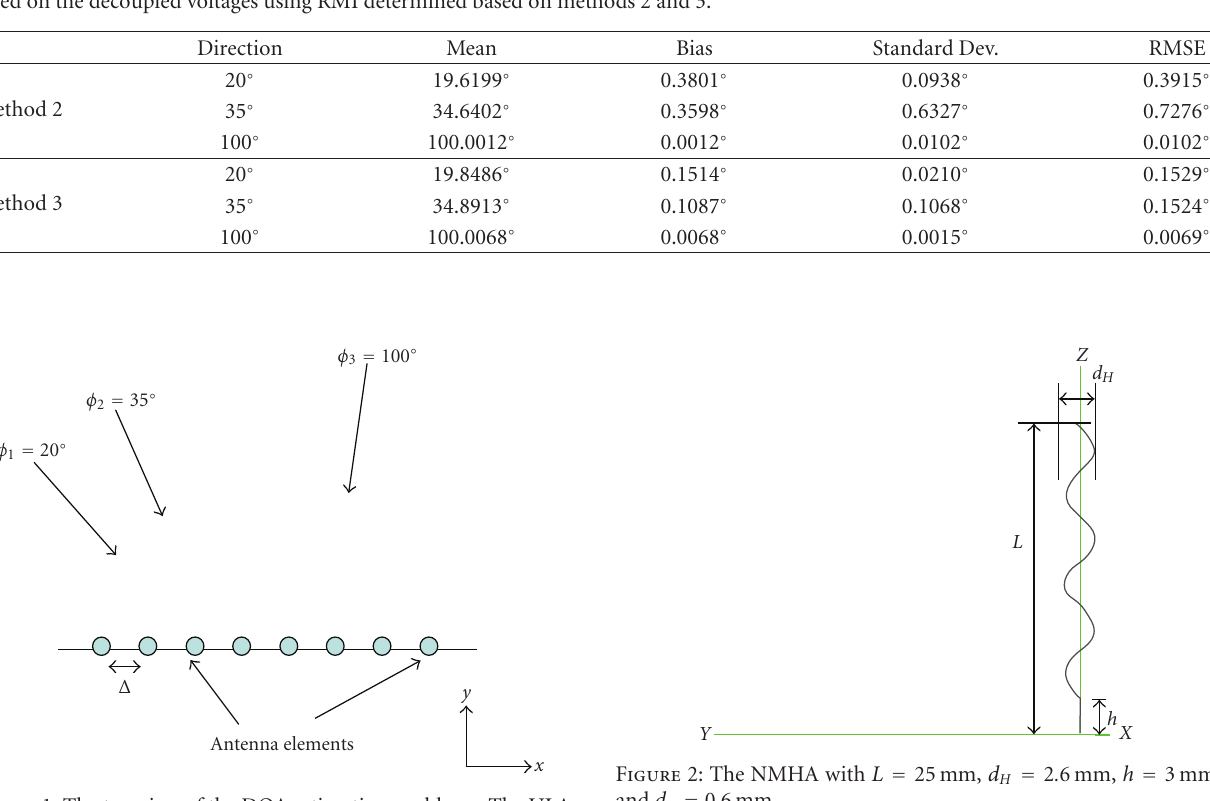
Figure 1: The top view of the DOA estimation problems. The ULA is lined in the x axis and the incoming signals are coming from the azimuth angles of φ 1 = 20 ◦ , φ 2 = 35 ◦ and φ 3 = 100 ◦ . The antenna separation is denoted as Δ .